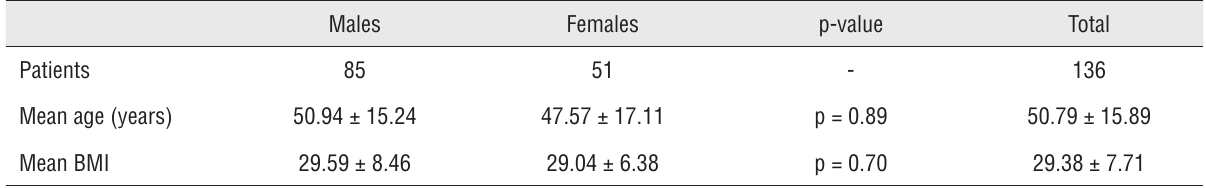
Table 1 - patient